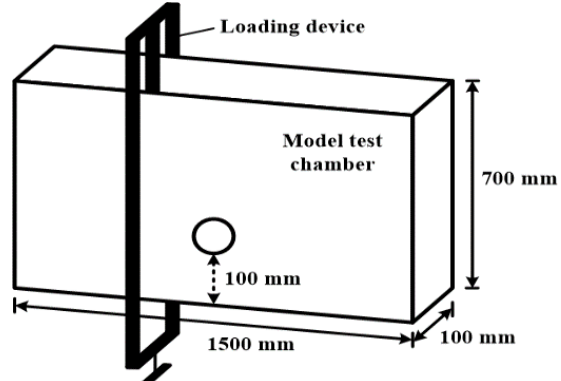
Figure 2. Size of model test chamber.